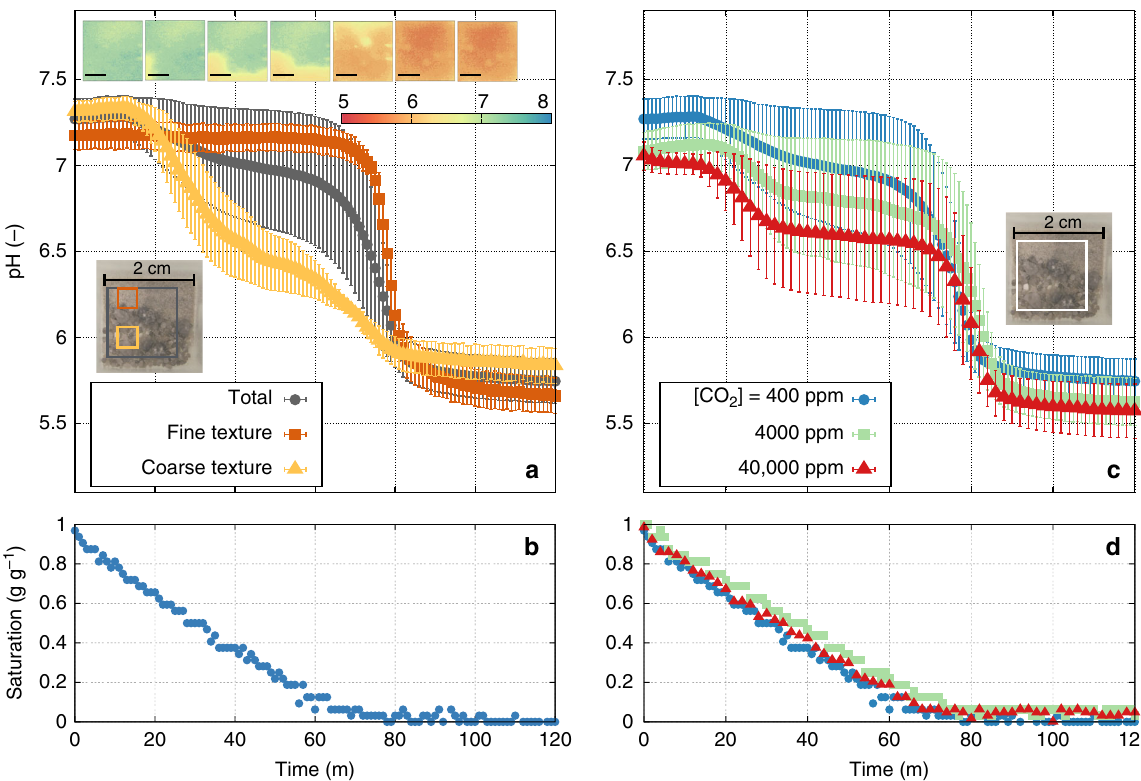
Fig. 4 pH localisation and dynamics during drying of quartz sand. Direct measurement of pH localisation and dynamics during desiccation of gamma-ray sterilised quartz sand of different textures under different partial pressure of carbon dioxid (pCO 2 ). a pH dynamics was analysed by averaging differnt regions with fi ne texture (0.08 – 0.2 mm, the red box in the inset image of a top view of the sample), coarse texures (0.7 – 3 mm, the yellow box in the inset), and the entire domain (labled as total, the grey box in the inset). Spaitally averaged pH values for each region are shown as symbols with error bars (±1 standard deviation). On the top of this fi gure, the dynamics of spatial pH maps during pH transition are given at 20 min intervals (the scale bar indicates 5 mm). b The saturation dynamics during evaporation de fi ned as the amount of water in the sample relative to the amount of deionised water applied for saturating the sample). c The variations in spatially averaged pH of the same sterilised quartz during drying for different levels of pCO 2 in the measurement cuvette. Error bars indicate ±1 standard deviation of the entire region (the white box in the inset image of a top view of the sample). d Saturation dynamics during desiccation for experiments conducted under different pCO 2